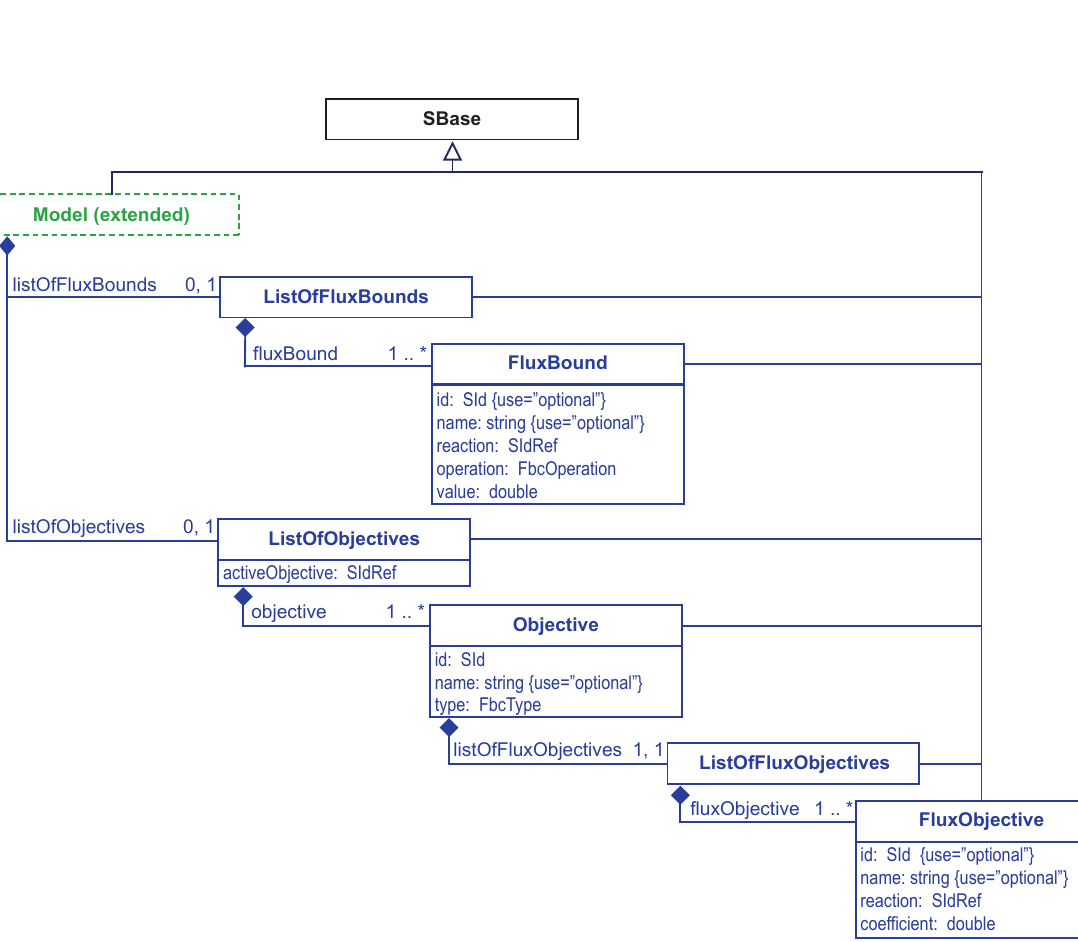
Figure 1: A UML representation of the Flux Balance Constraints package. Derived from SBase , the FBC classes inherit support for constructs such as SBML Notes and Annotation ’s. See Section 1.4 for conventions related to this figure. The individual classes are further discussed in the